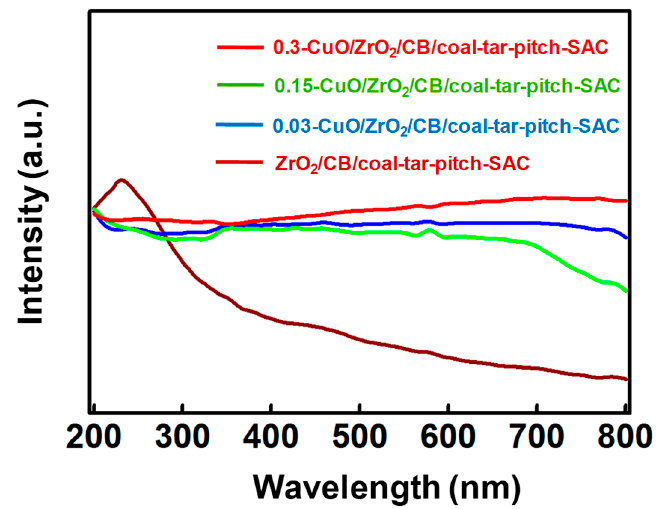
Figure 6. UV–Vis diffuse reflection spectroscopy (DRS) results of ZrO 2 /CB/coal-tar-pitch-SAC and CuO/ZrO 2 /CB/coal-tar-pitch-SAC powders. CuO/ZrO 2 /CB/coal-tar-pitch-SAC